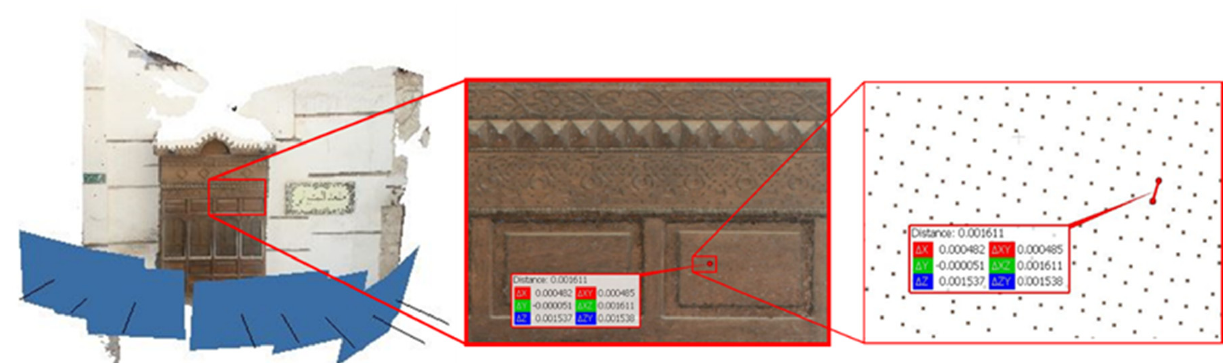
Figure 9. Ground sampling distance (GSD) of Roshan photogrammetric data.